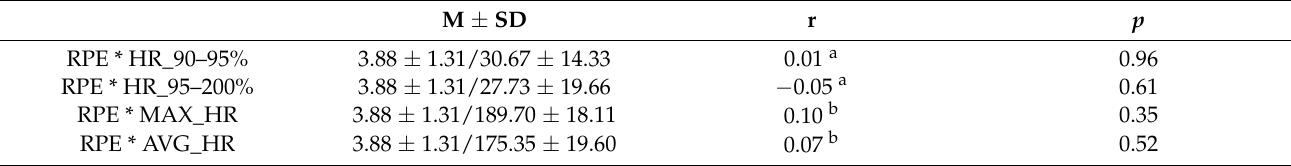
Table 6. Results of the correlation between subjective and objective